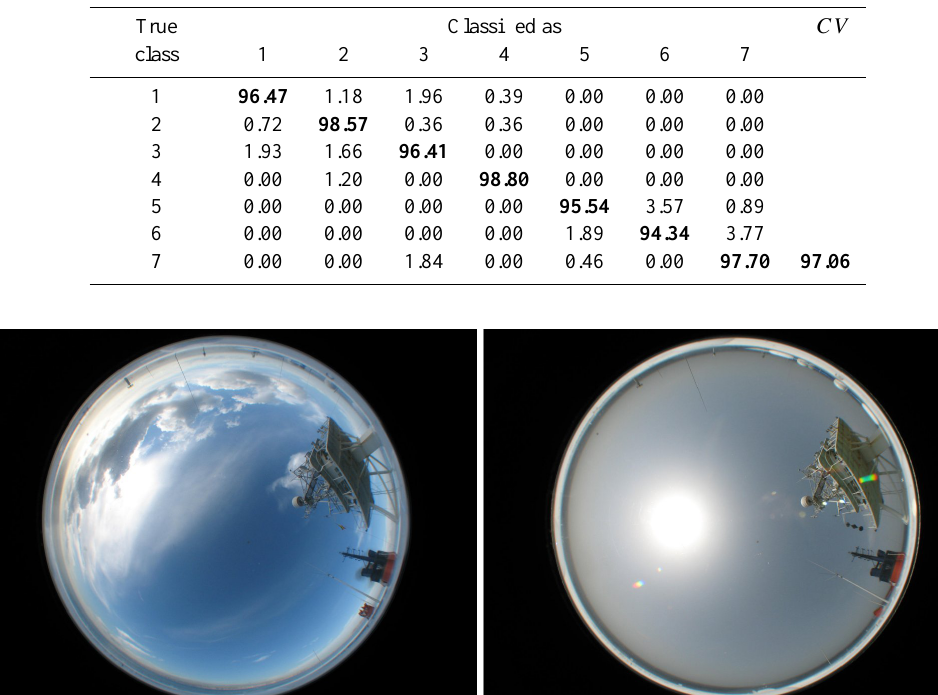
Table 1. Classes to be distinguished.